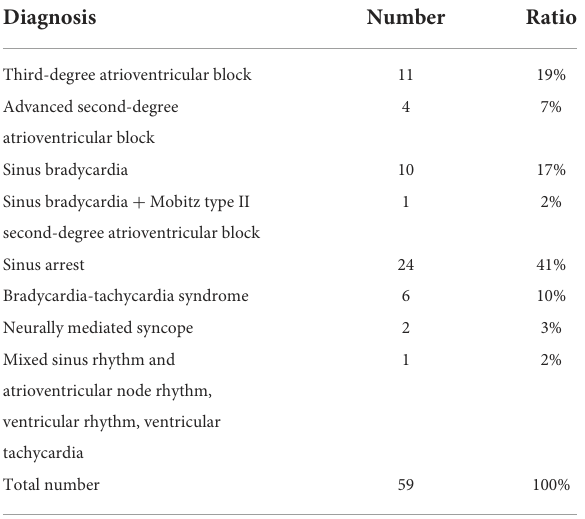
TABLE 4 Clinical symptoms before cilostazol administration and improvement after